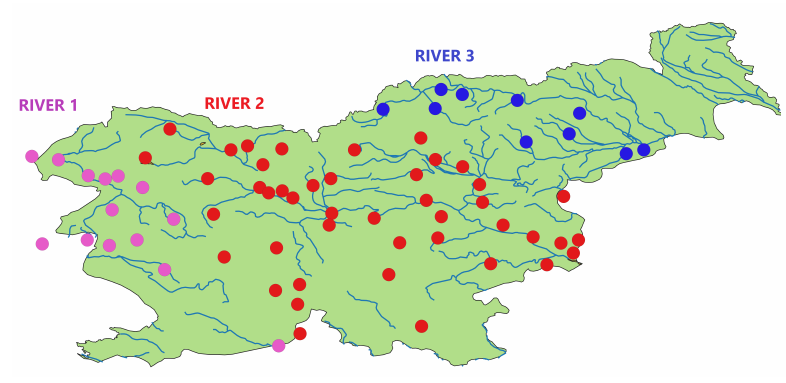
Figure 1. Sub-basins divided by